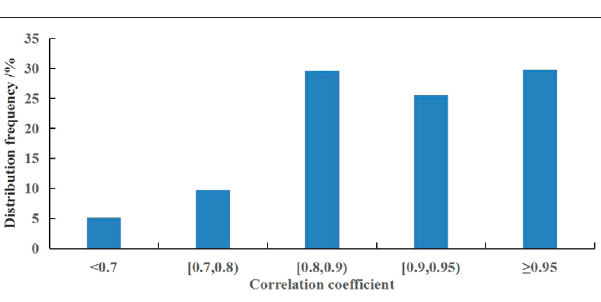
Frontiers in Environmental Science |